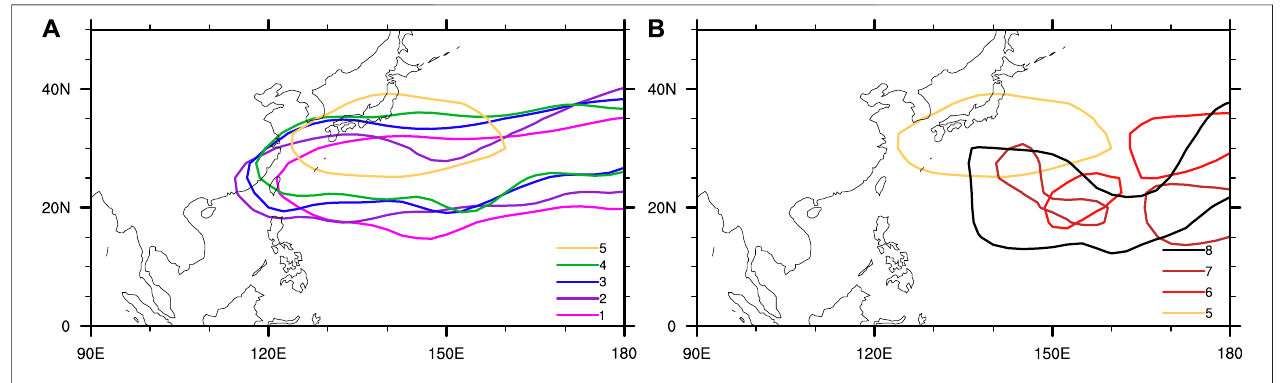
FIGURE 11 | As in Figure 2 , but for WPSH_SMI_40-50d